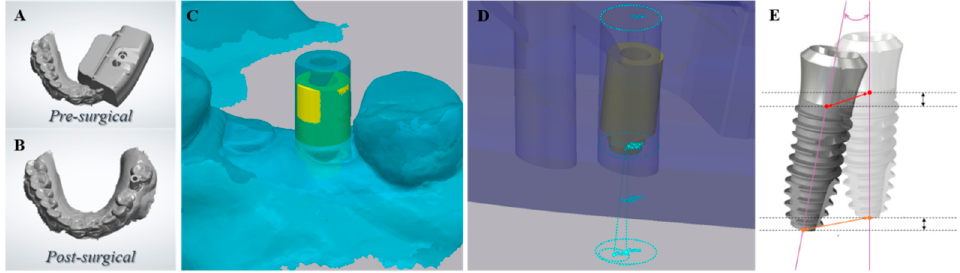
Figure 3. Measurement of the positional accuracy of the VARO guide surgery. ( A ) The pre-surgical plan data was uploaded to a dental CAD software. ( B ) The STL files from the postsurgical optical impression were also uploaded to the same software. ( C ) The data set was transferred to a 3D analysis software and superimposed using teeth as references. ( D ) The drilling hole from the pre-surgical data and the virtual abutment from the postsurgical data were used to “reverse engineer” the fixture positions. ( E ) The angular, vertical, and horizontal deviations were measured at implant apex and platform levels.